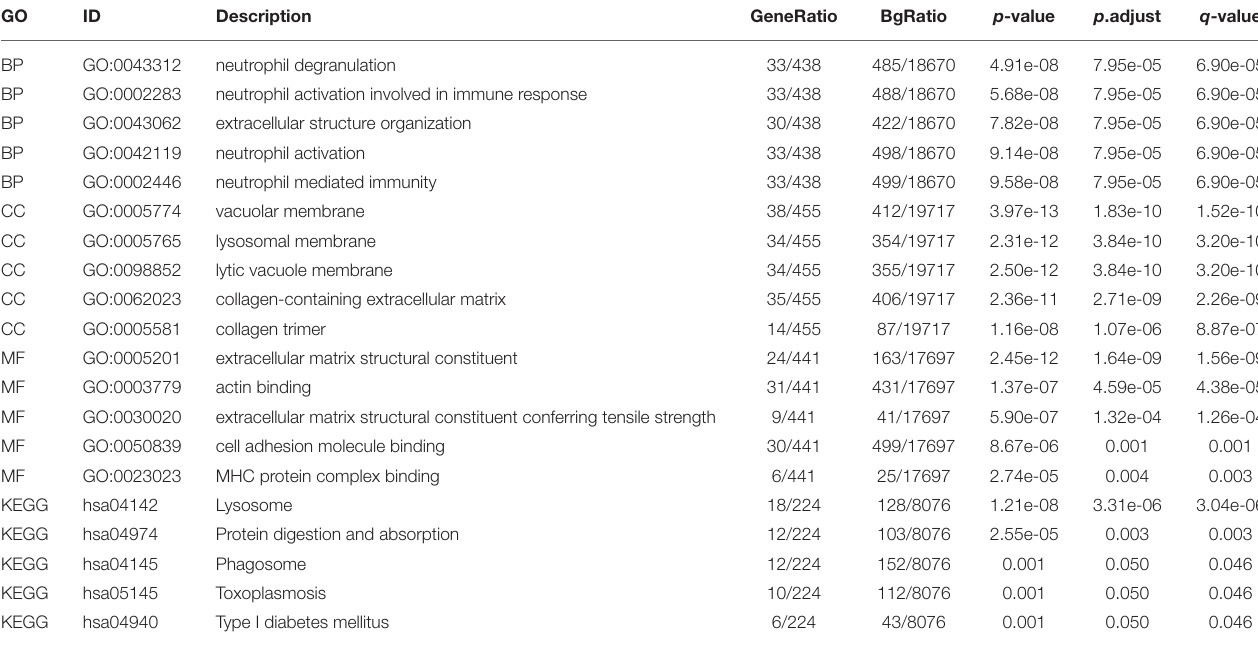
TABLE 1 | The significant GO and KEGG pathways enriched by 509